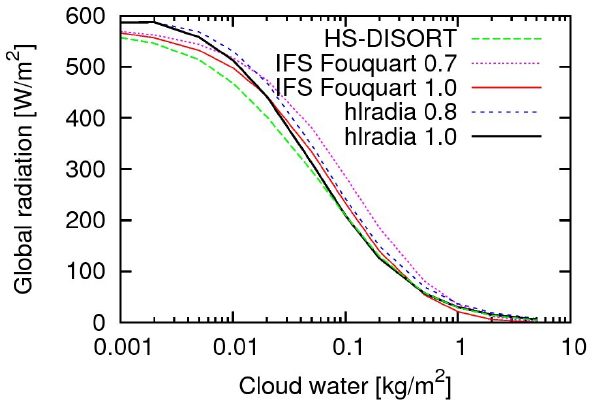
Figure 10. As for Fig. 9 but here the SW inhomogeneity factor is 1.0 in all cases. The results for HS-DISORT (red curve with +), IFS Fouquart (green curve with x), IFS Slingo (blue curve with *), IFS Nielsen (magenta curve with boxes) and hlradia (cyan curve with filled boxes) are shown. The vertical dashed line at 0.1kgm − 2 marks the cloud water load used in experiment 5 and 6 while the other line at 1.0 marks that used in experiment 7. Table 4. Absolute differences (unit: Wm − 2 ) for experiment 4. IFS- F, IFS-S and IFS-N refer to the IFS radiation scheme using the Fouquart (1987), the Slingo (1989) and Nielsen liquid cloud optical property parameterisation, respectively. Cl. wat. IFS-F IFS-S IFS-N hlradia [kgm − 2 ] diff. diff. diff.